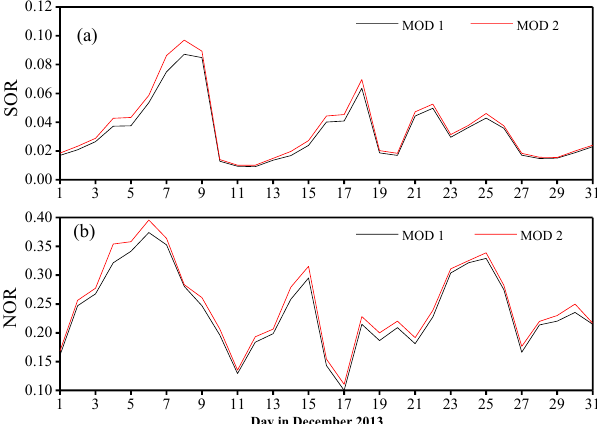
Figure 8. Daily variations in (a) molar ratio of sulfate to sum of sul- fate and SO 2 (SOR) and (b) molar ratio of nitrate to sum of nitrate and NO 2